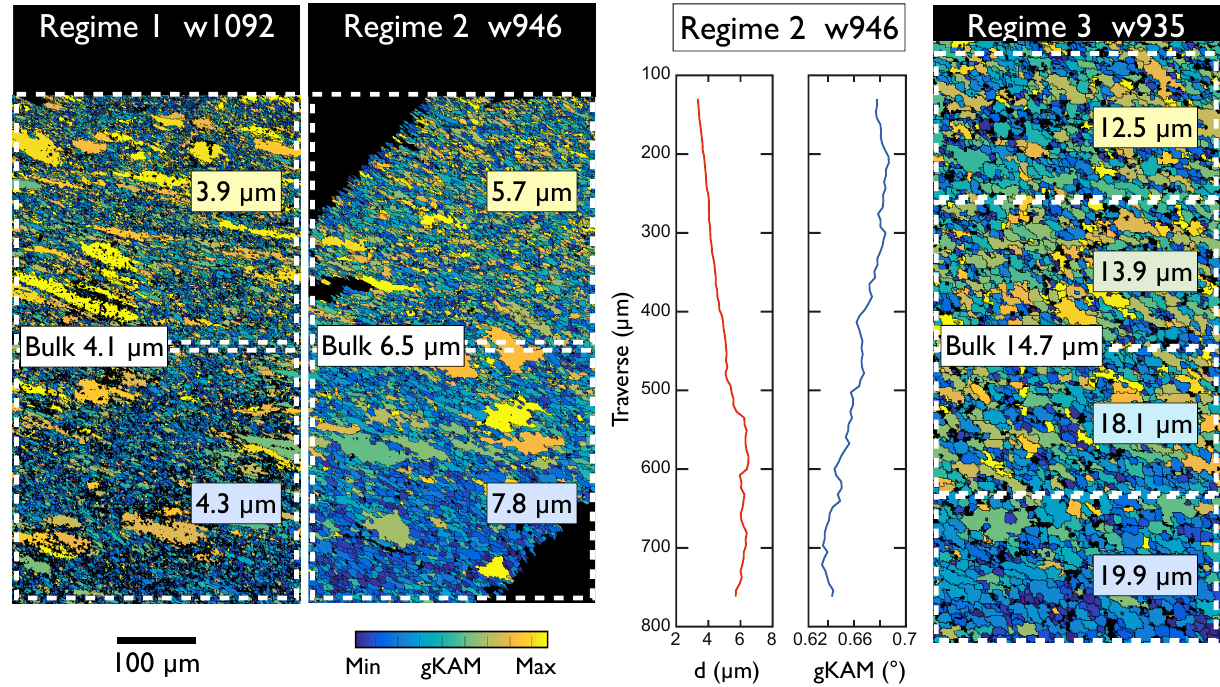
Figure 6. Recrystallized grain size as a function of misorientation density. Maps of grain kernel average misorientation (gKAM) are shown for three dislocation creep regimes. Maps cover nearly the full width of the shear zone. Gradients of gKAM are clearly visible. Modes of v(D) (size distribution of 3-D grains) are calculated for high- and low-gKAM sites in samples w1092 and w946 and for four different sites in sample w935. For sample w946, parallel traverses of grain size (RMS of 2-D equivalent diameters) and gKAM are shown. Scale bar and color coding of gKAM apply to